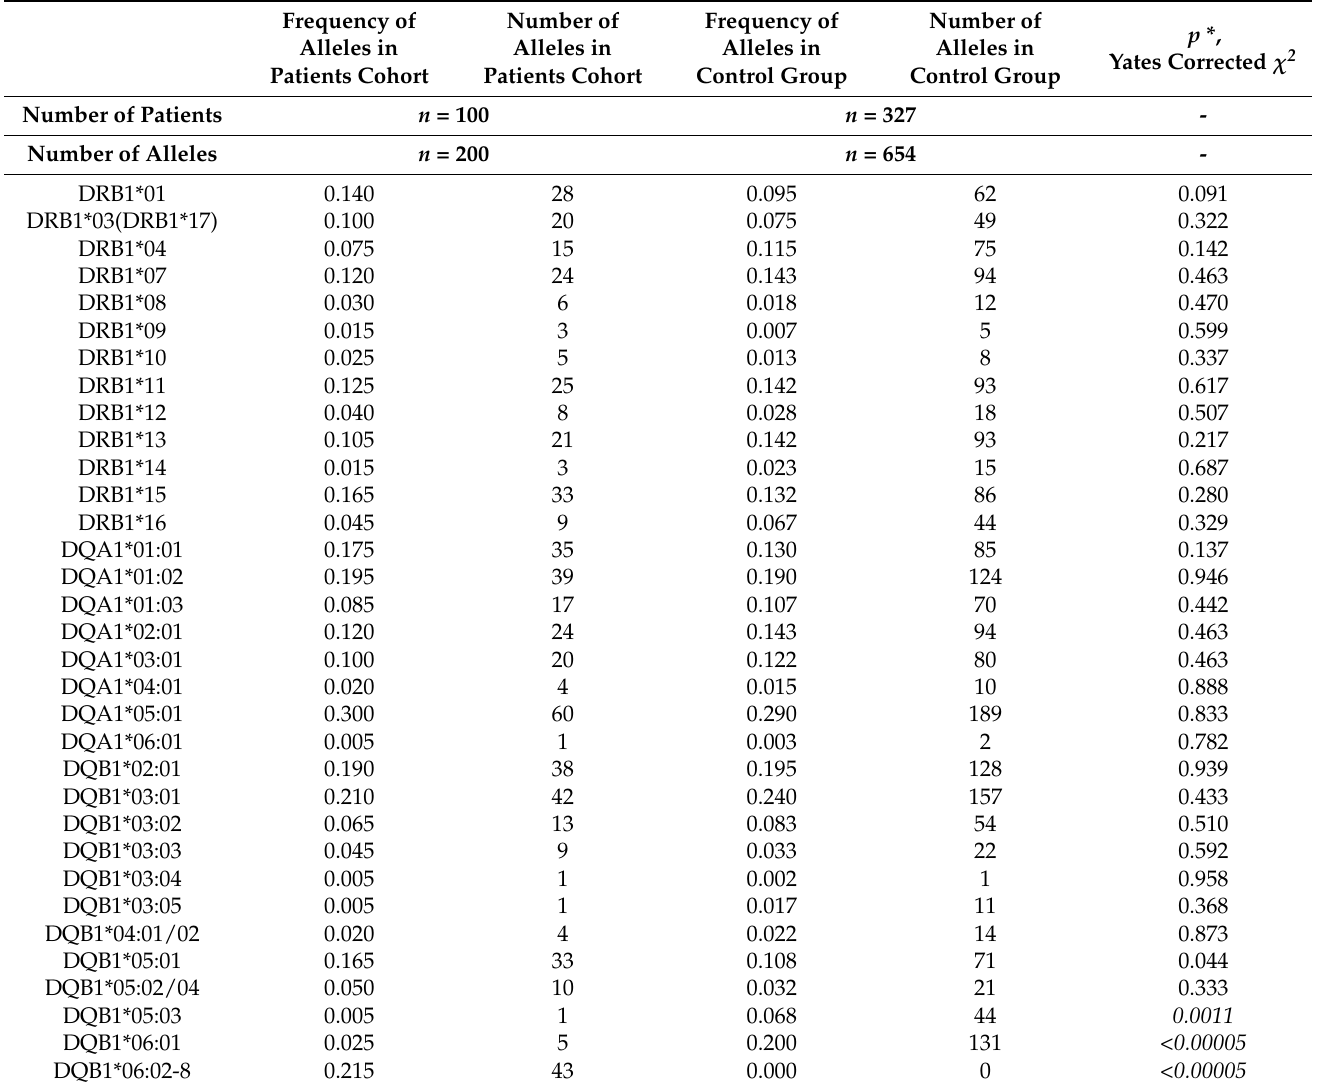
Table 3. Comparative analysis of frequencies of alleles of HLA class II genes in the examined cohort of patients and in the population control